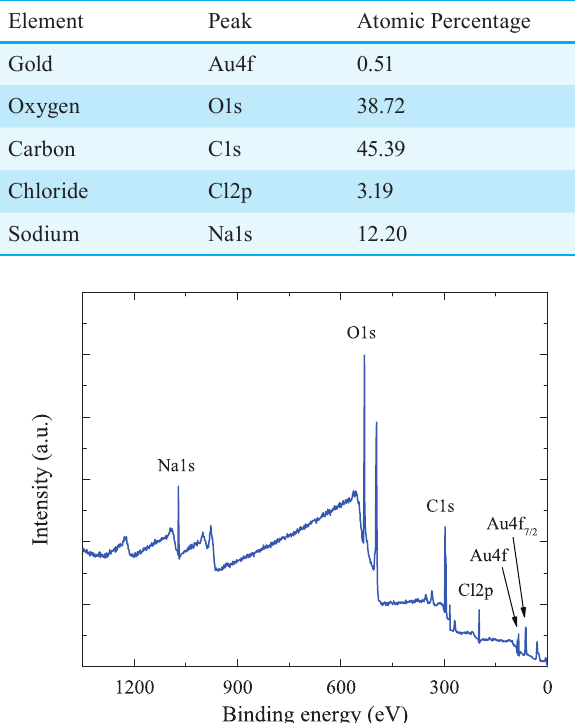
Fig. 4 XPS data of the 15 nm AuNPs sample.